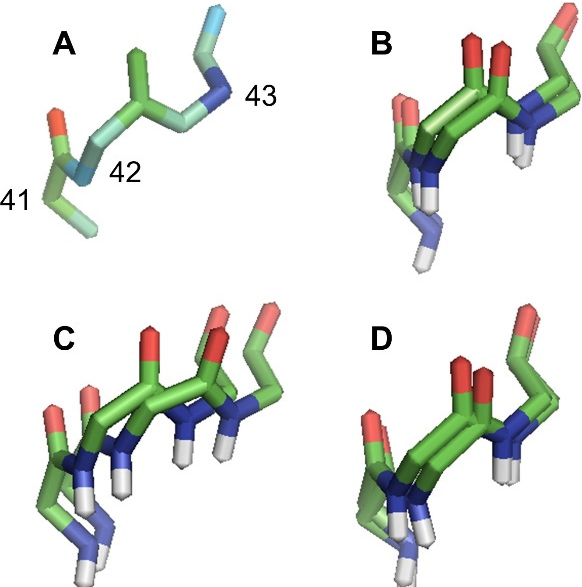
Figure 1. Backbone traces of residues 41–43 from Q8ZRJ2. ( A ) Crystallographic structure (PDB ID 2ES9) colored by a B-factor with blue being low, green being moderate, and red being high. Residue numbers shown in this panel reflect residue numbers in all panels. ( B ) FindCore superimposition of NMR ensemble (PDB ID 2JN8). This superimposition was calculated using a core atom set drawn from all heavy atoms (using all deposited models in the FindCore calculation) and not merely the residues shown. THESEUS superimposition, calculated from the entire MD trajectory using all heavy atoms, of MD trajectories simulated using the AMBER force field, showing snapshots 100 and 1000, at ( C ) 100 K and ( D ) 300 K. In panels ( B – D ), carbonyl oxygens are red, amide nitrogens are blue,